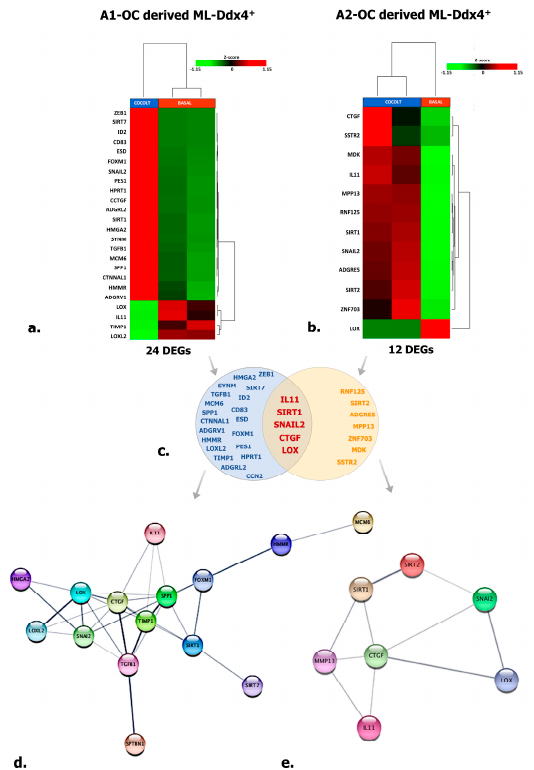
Figure 5. Targeted RNAseq of A2780 conditioned by ML-Ddx4 + cells. The image shows Figure 5